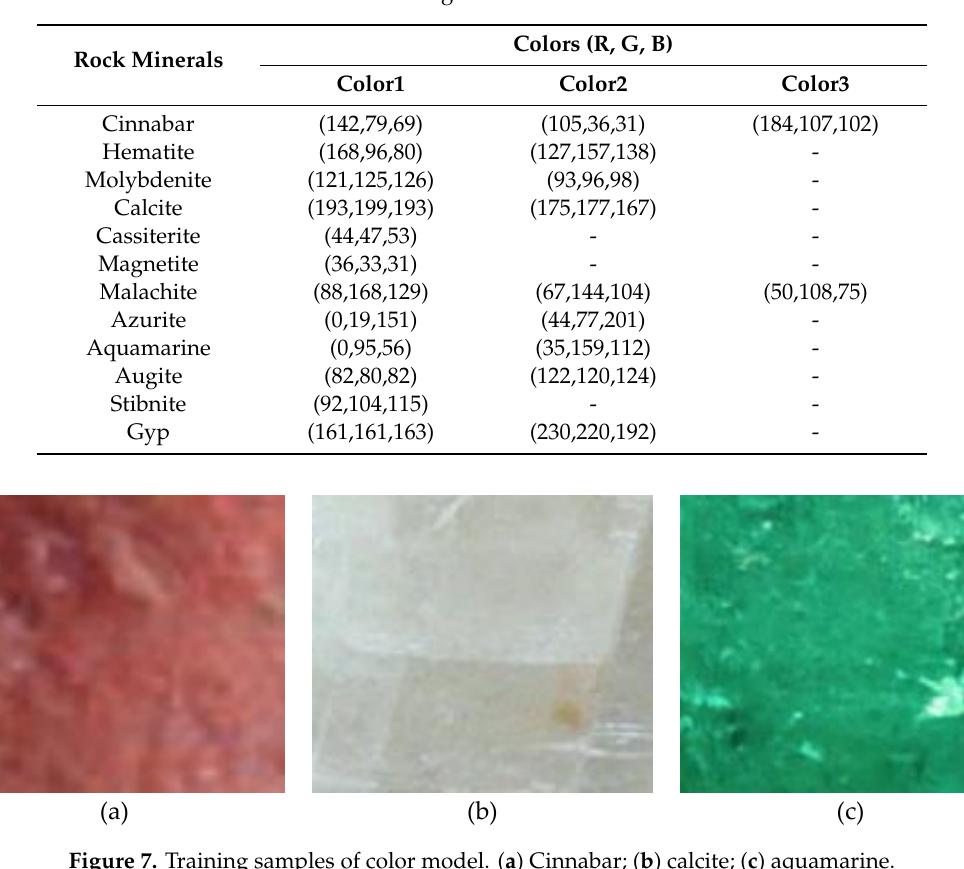
Table 3. Training results of color model.